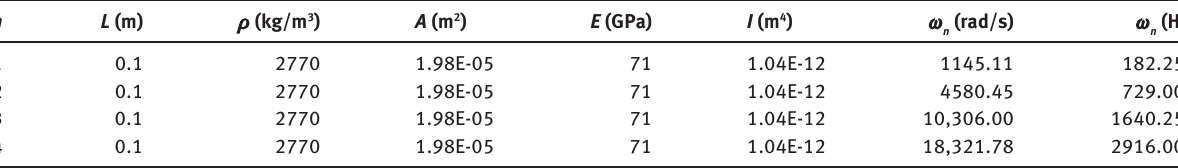
Table 2: Data used to obtain frequency for simply supported beam in classical